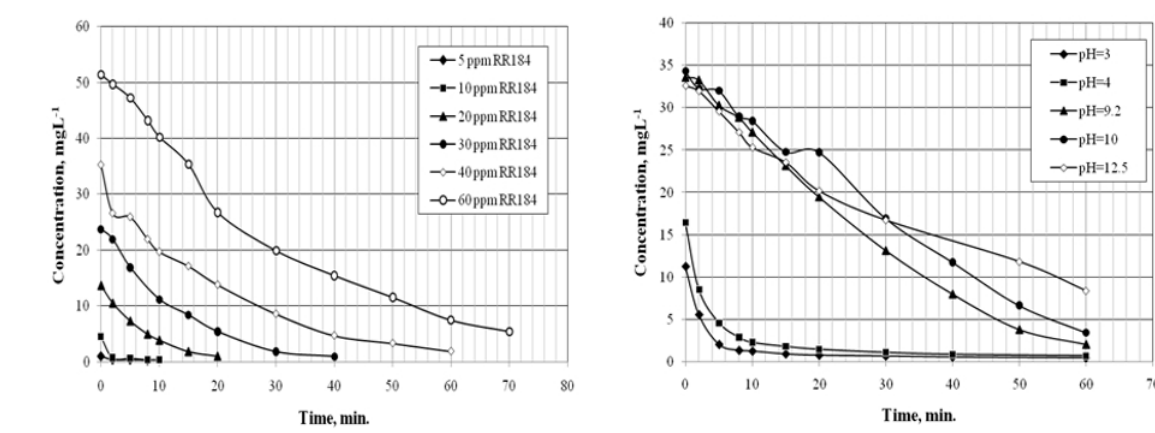
Figure 6. The influence of pH on the photodegradation process.